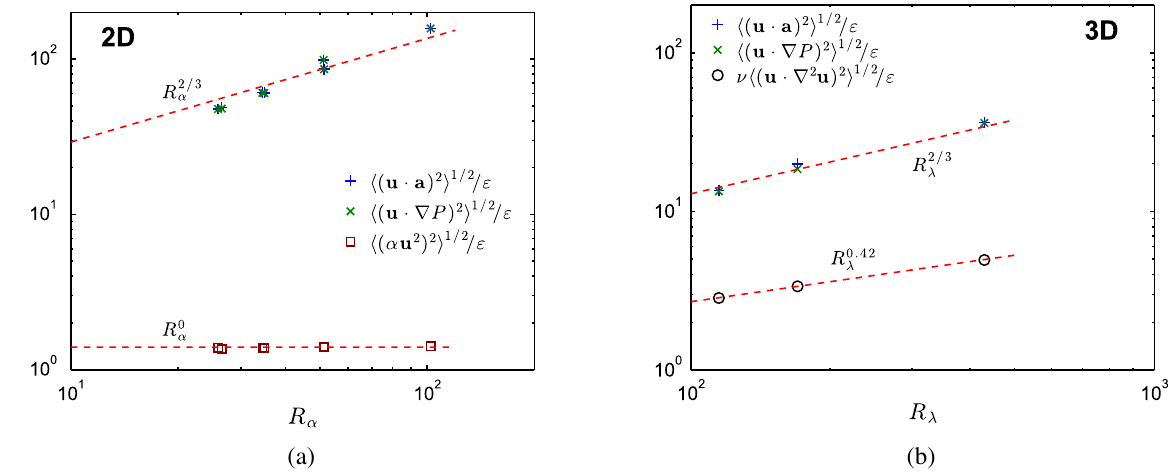
FIG. 2. Variation of the standard deviations of u · a = ε (blue pluses), u · ∇ P= ε (green crosses), ν u · ∇ 2 u = ε (black circles), and α u 2 = ε (brown squares) as functions of Reynolds numbers in both (a) 2D and (b)